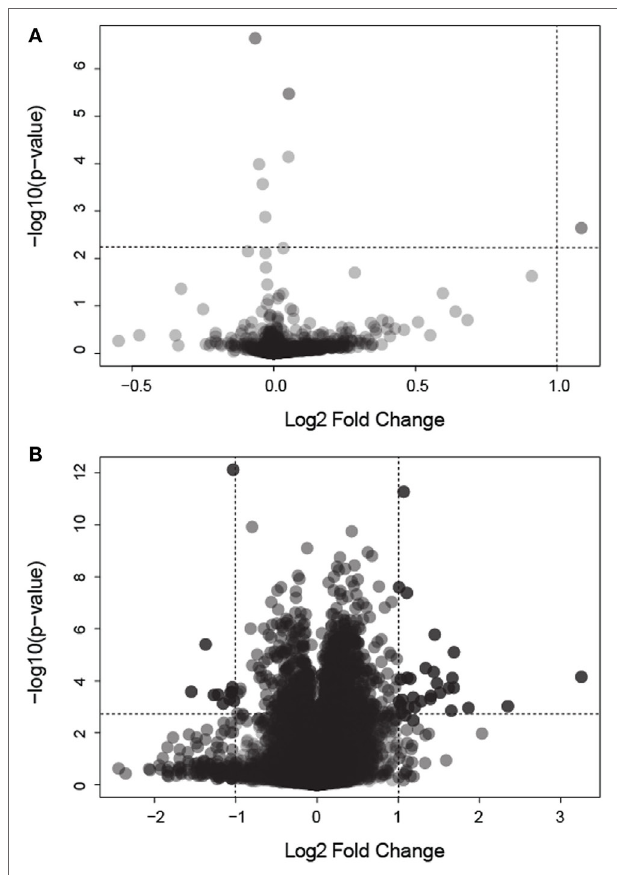
FigUre 1 | Volcano plot depicting differentially expressed genes (DEGs) in mosquitoes submitted to different feeding regimens. (a) Comparison of blood-fed (BF) vs. uninfected mosquitoes. (B) Comparison of BF vs. non-BF mosquitoes. All data were log2 transformed. Dotted lines represent the significant p -value and fold change cutoffs used to identify DEGs (see Materials and